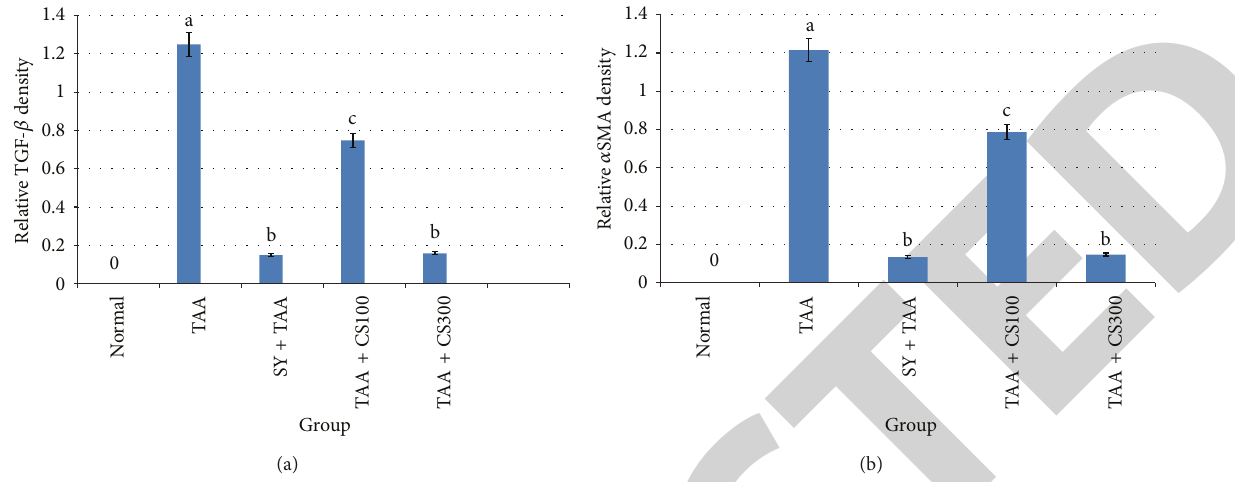
Figure 5: Protein expressions from western blots in all experimental groups are quantitated using Image J program. (a) TGF- 𝛽 1 density. (b) 𝛼 SMA density. The data were stated as mean ± S.E.M. ( 𝑛 = 3 ). Means with different superscripts are significantly different. a 𝑃 < 0.05 versus normal control group and b 𝑃 < 0.05 versus TAA control group. SY stands for Silymarin (standard hepatoprotective drug).